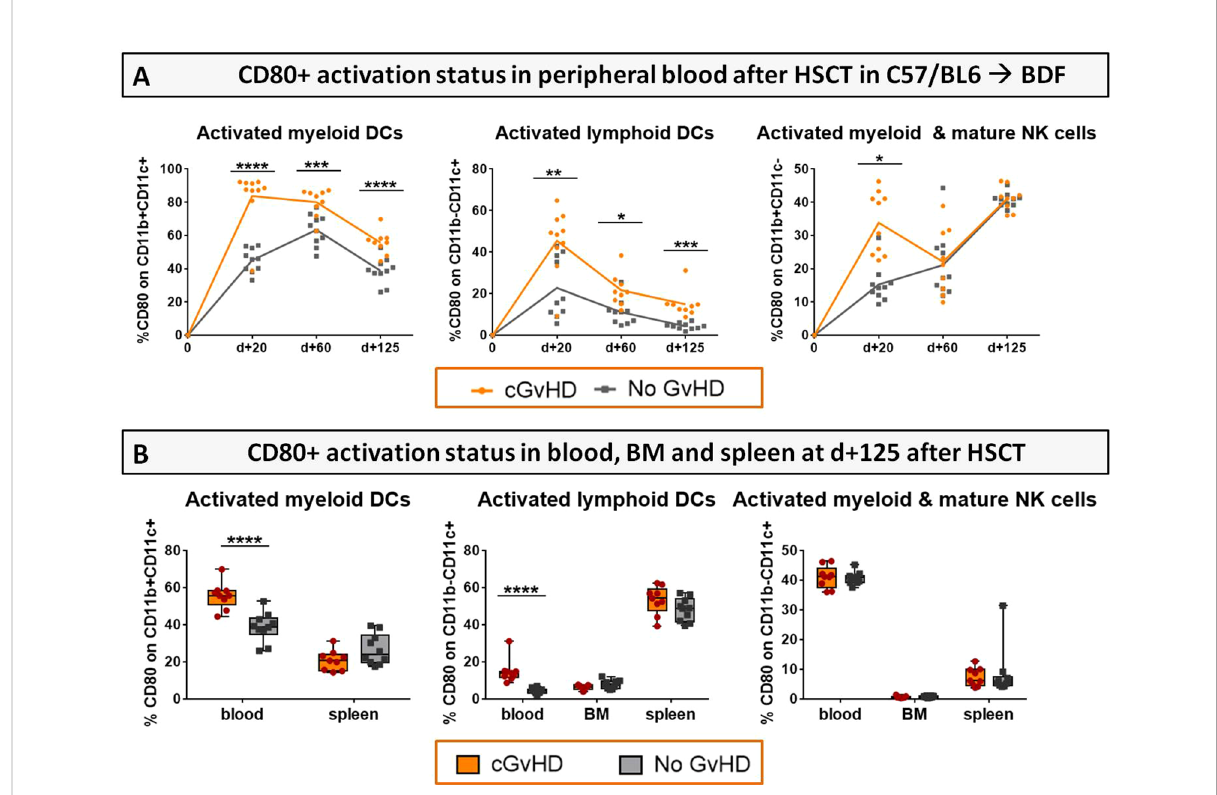
FIGURE 10 Activation status (CD80+) of DCs and NK cells in cGvHD in C57BL/6 ➔ BDF1. (A) CD80+ expression on immune cell subsets in the PB over 125 days and (B) in PB, BM and spleen at d+125 after syn- and allo HCT. Blood was collected by tail vein bleeding or retrooribitally upon fi nalization. Spleens were harvested and BM fl ushed from tibia and femur. Immune cells were isolated, stained with the respective FACS-antibodies and samples were analyzed with fl ow cytometry DCs, dendritic cells; NK, natural killer cells. n=9 (cGvHD); n=10 (No GvHD).Error bars represent mean ± SEM. Representative data from one out of four experiments. *P<0.05, **P<0.01, ***P<0.001, ****P<0.0001 by unpaired students